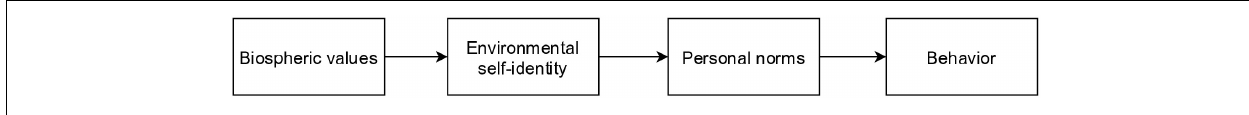
FIGURE 1 | The relationship between environmental considerations and behavior (adapted from van der Werff and Steg, 2016).